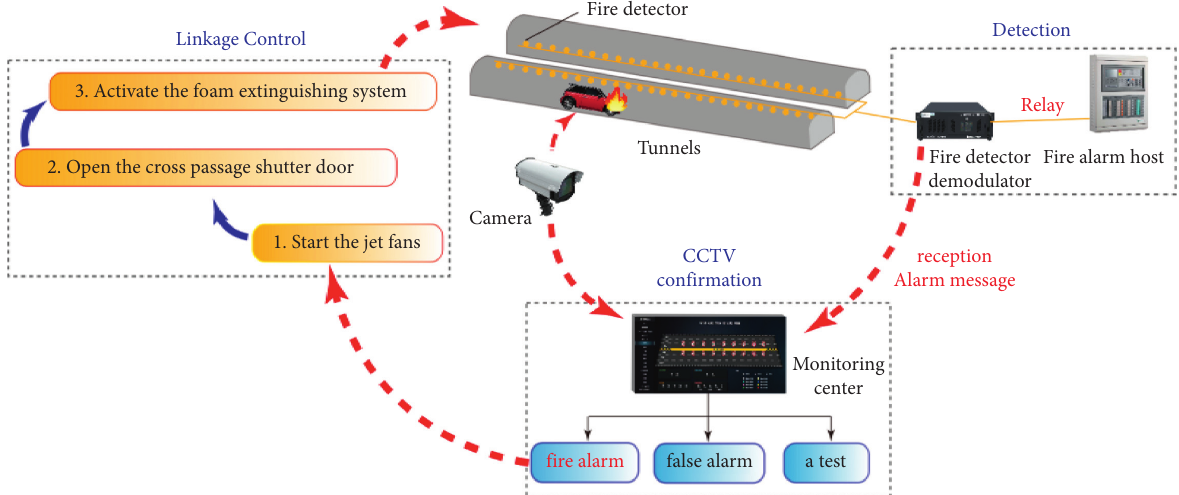
Figure 1: Linkage flow of tunnel fire control